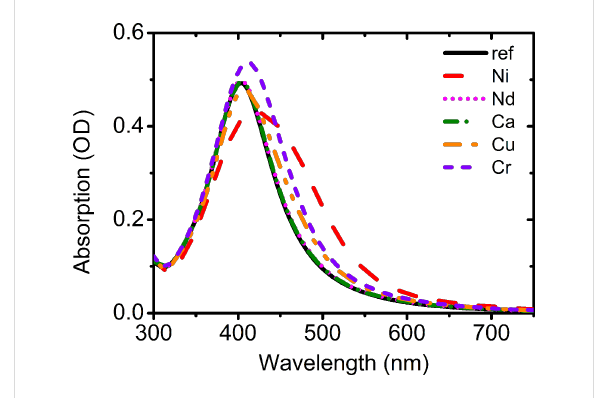
Figure 6: Absorption spectra of the AgNP-3MPS (synthesis b) solu- tion with 1 ppm ion